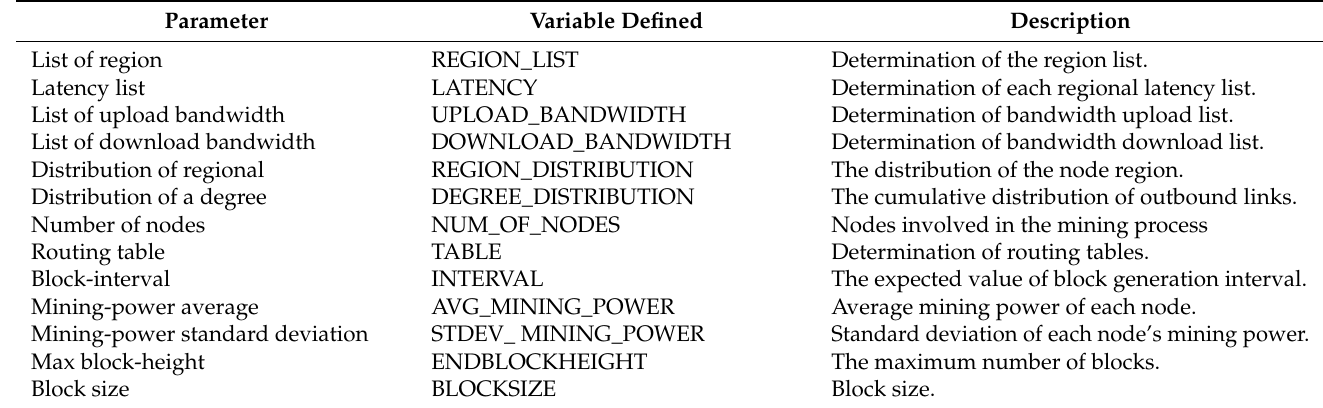
Table 2. SimBlock simulator parameter setting.